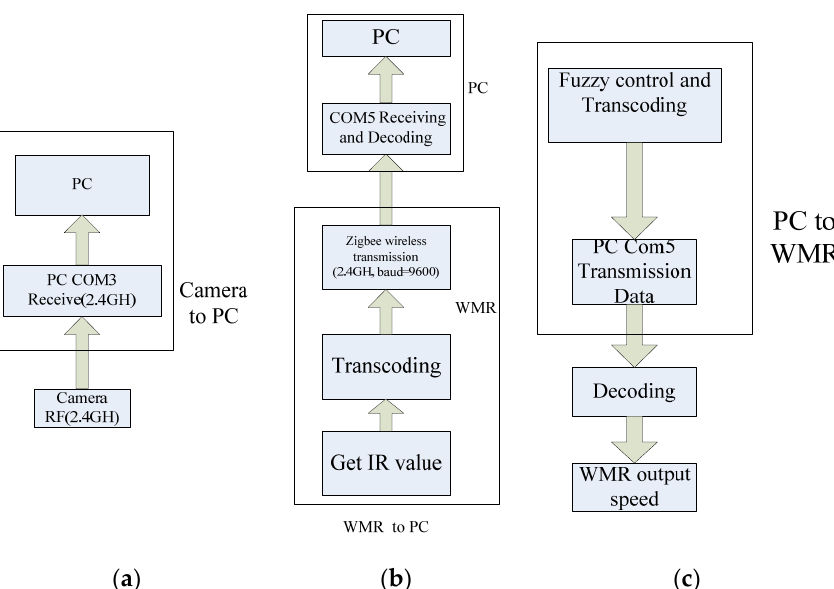
Figure 15. ( a ) Camera transmits images to the PC; ( b ) Infrared data transmission from WMR to PC; ( c ) Command signal is calculated and sent to the WMR.